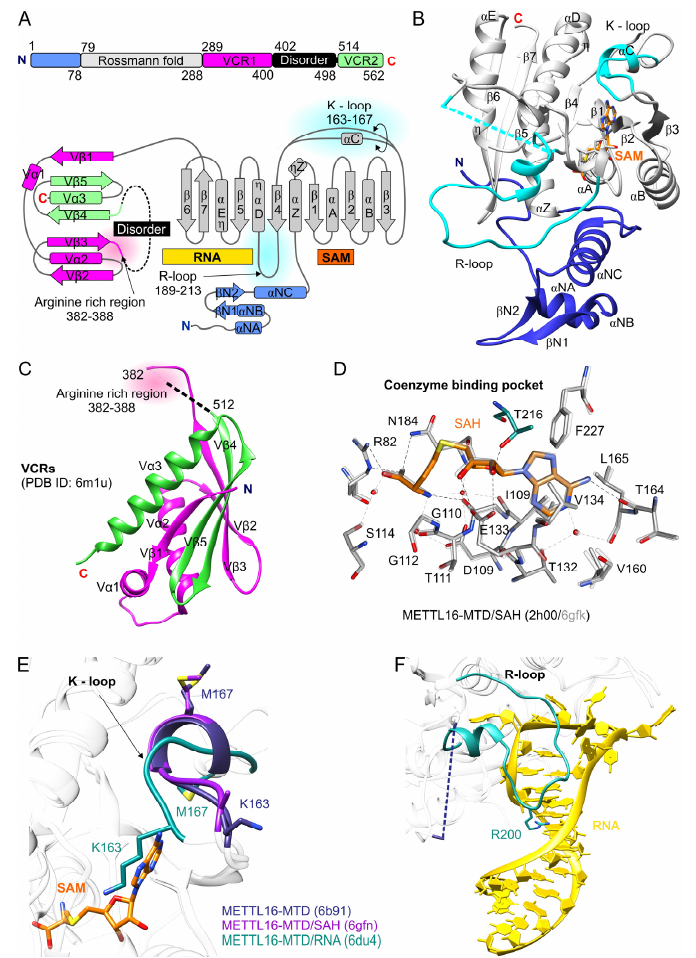
Figure 1. The structure of METTL16. ( A ) Scheme of the overall domains’ organization and topology diagram of human METTL16 [29,36] ( B ) The 3D structure of METTL16 is a composite of three superposed models: apo-METTL16-MTD (PDB ID: 6b91), METTL16-MTD/SAH (6gfn), METTL16- MTD/RNA (6du4)—RNA is not shown; METTL16 is shown as ribbons and structural elements are color-coded as in panel A. Dashed cyan line represents disordered residues 189–213 (R-loop) in apo form of METTL16-MTD. ( C ) Crystal structure of vertebrates conserved regions (VCRs) located in the C-terminal domain of METTL16; the arginine-rich region is indicated. The dashed black line represents predicted disordered residues 402–498. ( D ) The network of interactions secures the orientation of SAH in the METTL16 coenzyme binding pocket. The model presents interactions in the 2h00 structure (residues-gray, SAH-orange) and superposed 6gfk (transparent gray). Residue T216 (turquoise) is modeled from METTL16-MTD/hp1x (6du4) structure. Black dashed lines show direct interactions between METTL16 and the coenzyme, contacts mediated by water molecules (red/gray dots) are shown by gray dashed lines. ( E ) Conformational rearrangement of the K-loop between apo-METTL16-MTD (6b91, dark purple), METTL16-MTD/SAH (6gfn, dark pink) and METTL16- MTD/hp1x (6du4, turquoise) complexes. Upon RNA binding K163 is placed inside the SAM binding pocket. The K-loop is highlighted and shown by ribbon representation; crucial residues of this motif, K163 and M167, are presented as sticks. ( F ) The R-loop in the METTL16-MTD/hp1x complex (6du4, turquoise) is shown in ribbon representation. R200 is shown as sticks. Dashed dark purple line represents the disordered R-loop existing in the apo structure of METTL16. All molecular figures were created using UCSF Chimera